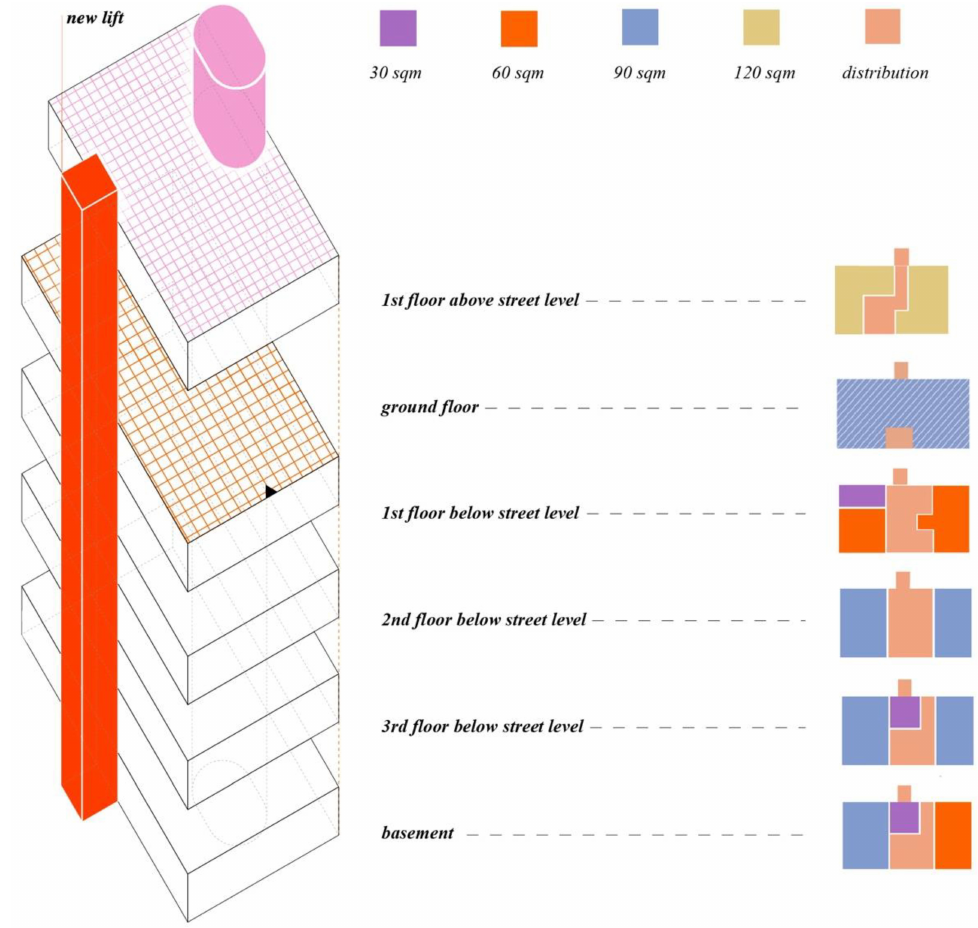
Figure 8. Definition of a reuse scheme (the modules—and their colours—are specified in Table